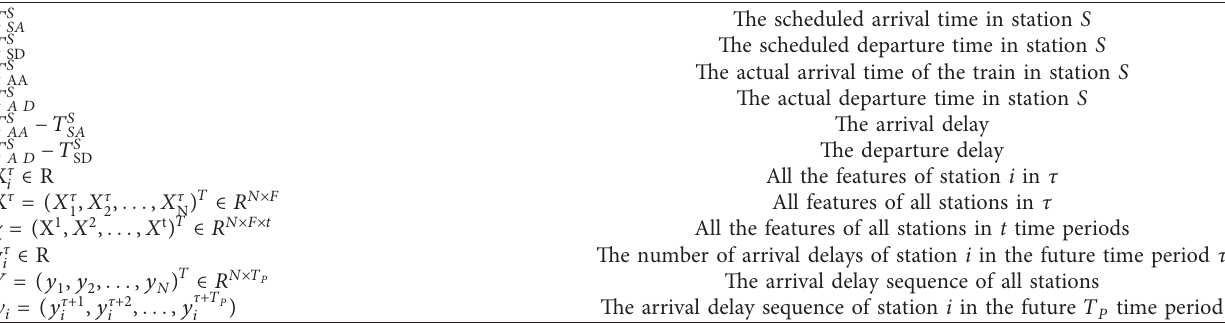
Table 1: Some notation definitions.